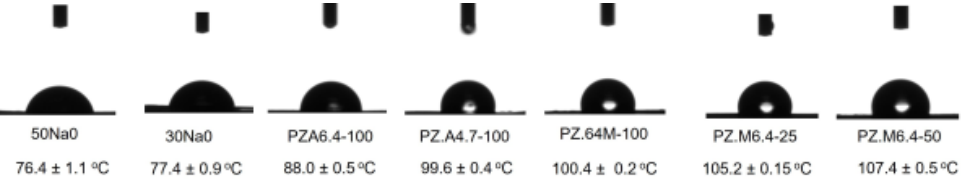
Figure 9. Contact angle images of BSA-loaded hydrogels.